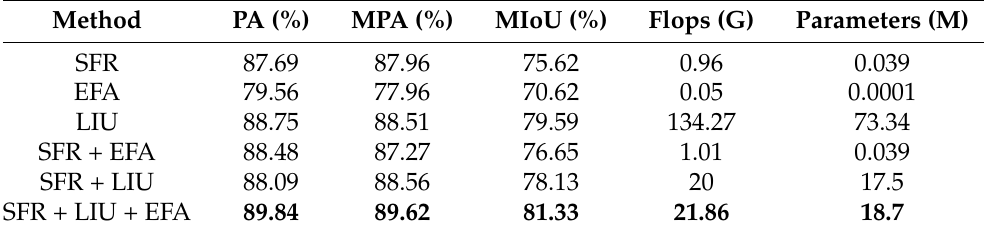
Table 2. Ablation experiment.